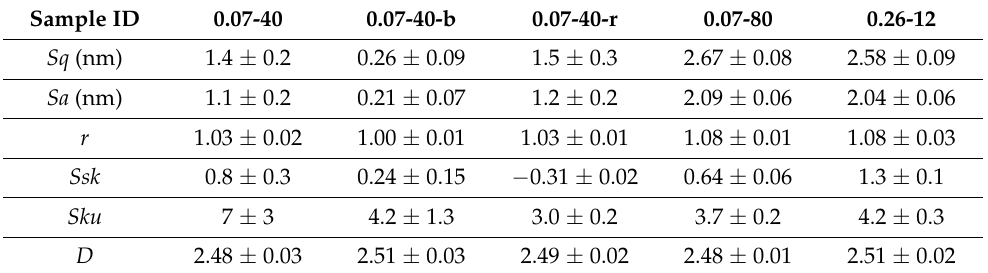
Table 2. Surface statistical parameters calculated from the AFM images of the different samples. Values represent averages over four AFM images taken at different sample surfaces with standard deviations given as